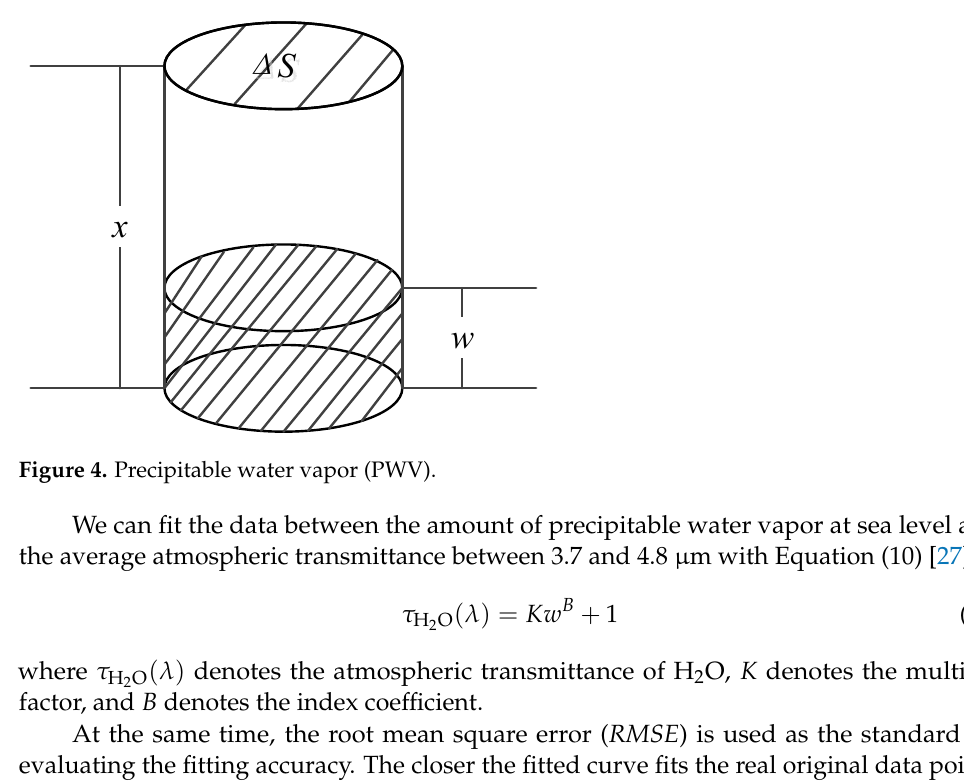
Table 1. Fitting coefficient of PWV and atmospheric